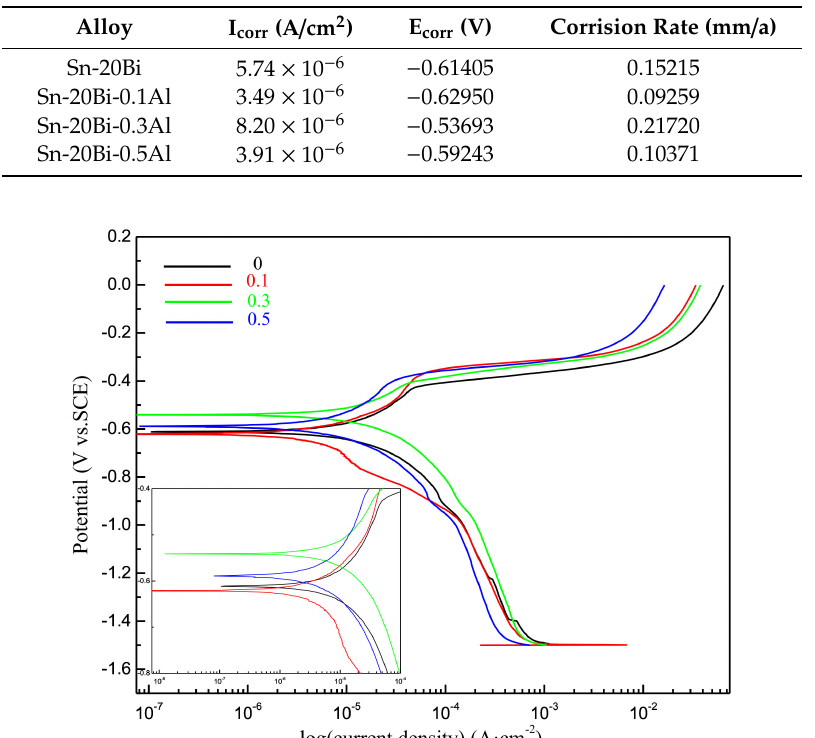
Figure 8. Potentiodynamic polarization curves of Sn-20Bi-xAl (x = 0, 0.1, 0.3, 0.5) solder